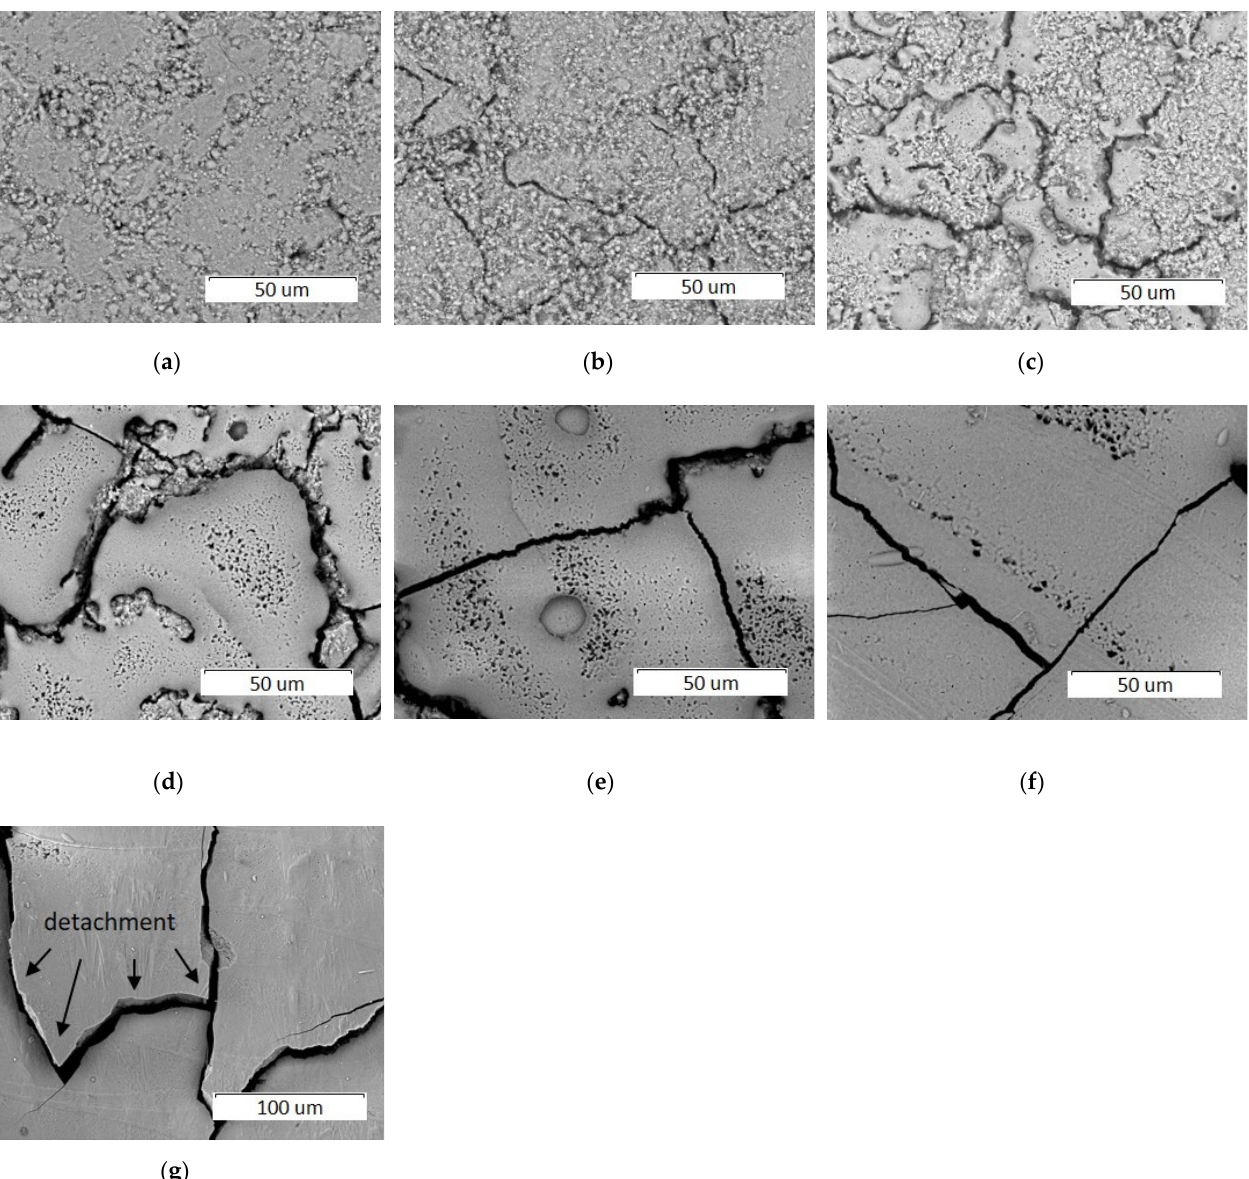
Figure 5. SEM images of pellet surface before ( a ) and after treatment by a 0.25 mm laser spot at a power of 4 W and at different scanning speeds, mm/s: ( b ) 600; ( с ) 500; ( d ) 300; ( e ) 200; ( f ) 100; and ( g ) 50. Table 3. Exposure values (J/cm 2 ) for different modes of pellet surface treatment at a laser power of 4 W. Diameter of Laser Spot Scanning Speed (mm/s)